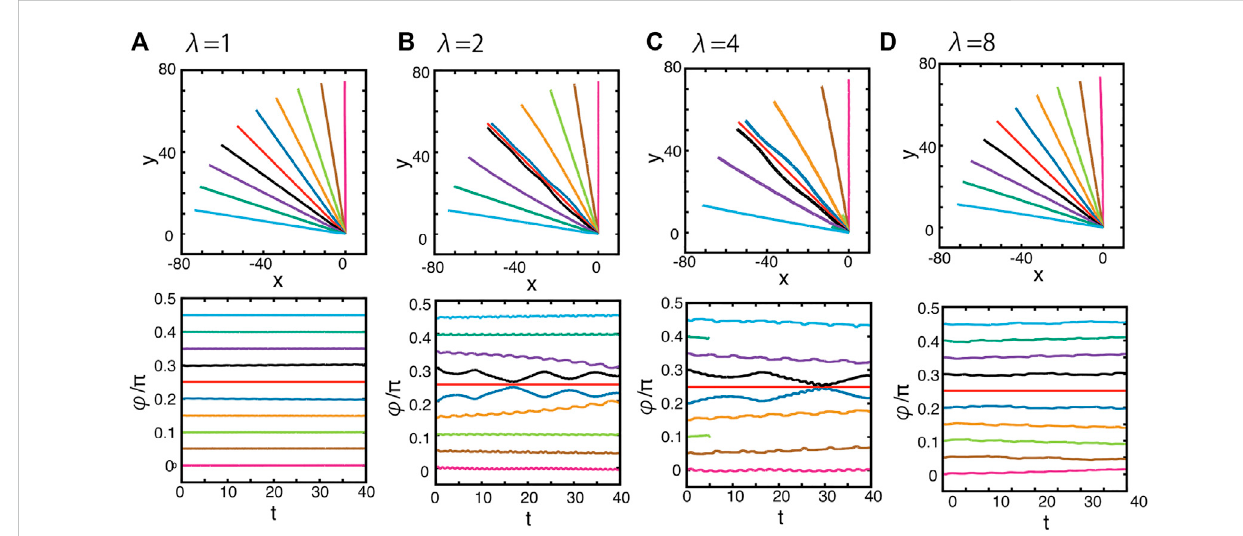
FIGURE 8 Dynamics of the squirmer near a surface with the doubly periodic sinusoidal wave topography of Eq. 5, as depicted in Figure 2B. The surface topography amplitude is given by A = 0.1, and the wavelength is (A) λ = 1, (B) λ = 2, (C) λ = 4, (D) λ = 8. (Top panels) the projections of the squirmer trajectories onto the x – y plane with different initial orientation angles, φ , as de fi ned via Figure 5. These initial angles may be inferred from the initial tangents of the plotted projected trajectories. (Bottom panels) the time evolution of the orientation angle φ . Different colours index different initial